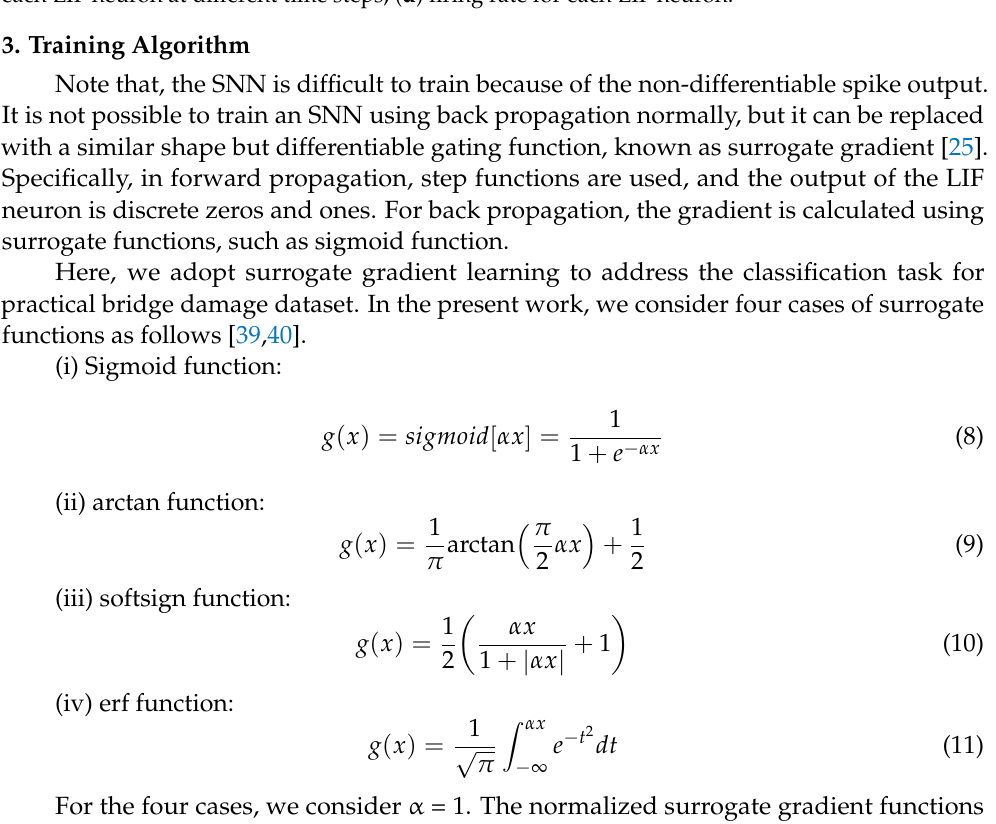
Figure 3. ( a ) External stimulus for each LIF neuron, ( b ) membrane voltage, and ( c ) spike emission for each LIF neuron at different time steps, ( d ) firing rate for each LIF neuron.